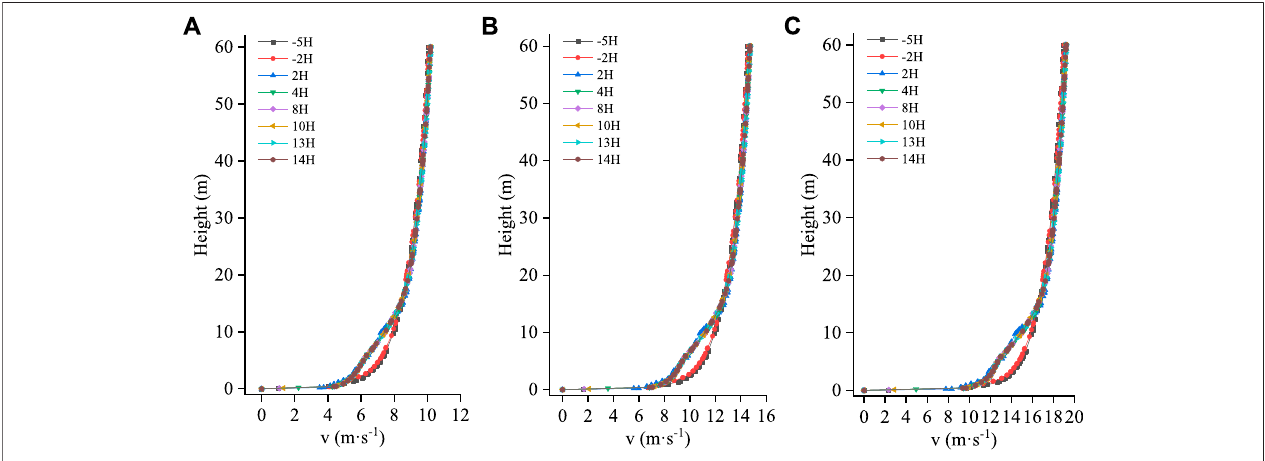
FIGURE6| Windvelocitypro fi levariationsatdifferentpositionsofsingle-rowforestbeltunderdifferentincomingwindvelocities. (A) :V=8 m · s − 1 , (B) :V=12 m · s − 1 , (C) : V = 16 m · s − 1